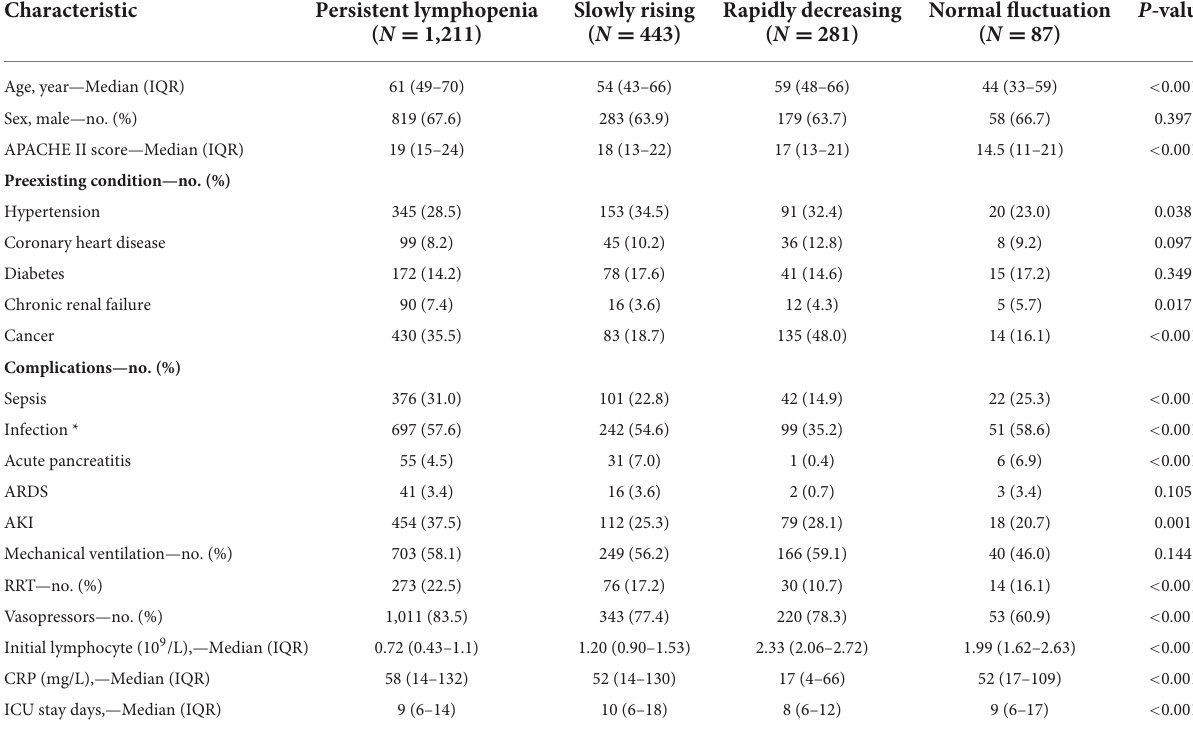
TABLE 1 Baseline characteristics in four ALC trajectory